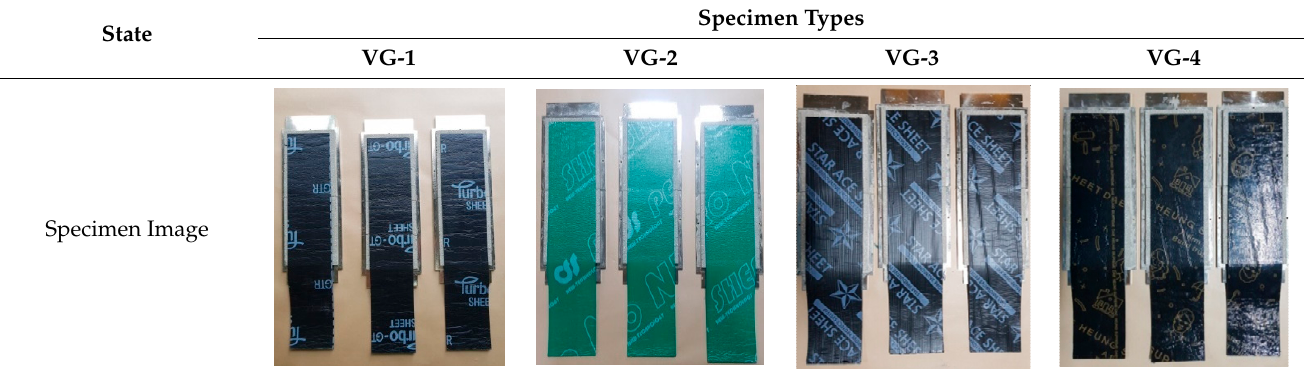
mixing ratio (C:S:W = 1:2.45:0.5), the base mortar specimen was cast with a thickness of 320 mm × length 120 mm × thickness 6 mm, and after 14 days of settling (curing period). Figure 6. The production of mortar substrates and specimens for exclusive molds; ( a ) molds for substrate, ( b ) mortar pouring as substrate, ( c ) after curing of mortar substrate, ( d ) specimen applied waterproofing sheet. Table 3. The 4 types NHV-SPRG composite waterproofing sheets applied on substrate specimens.